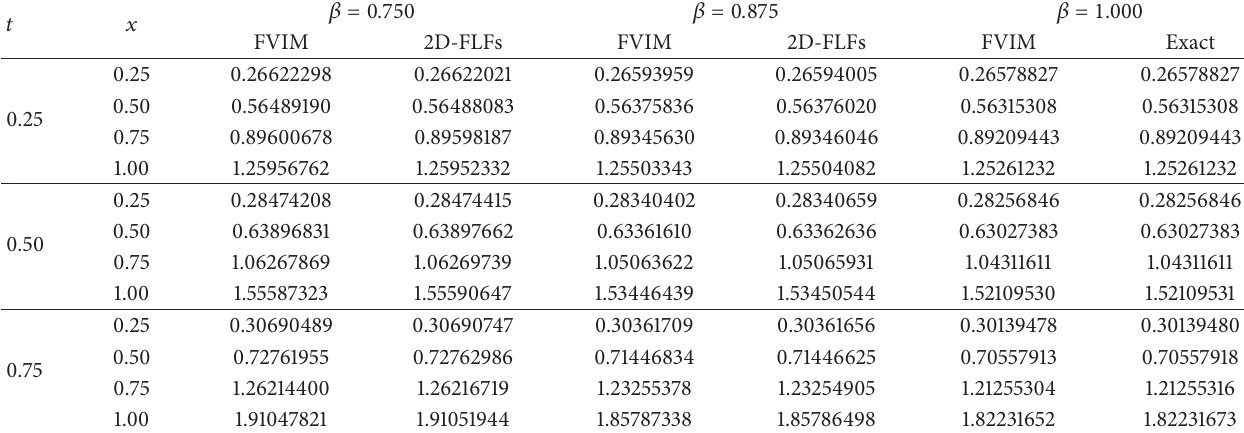
Table 3: Numerical values when 𝛽 = 0.750, 0.875, and 1.000 for